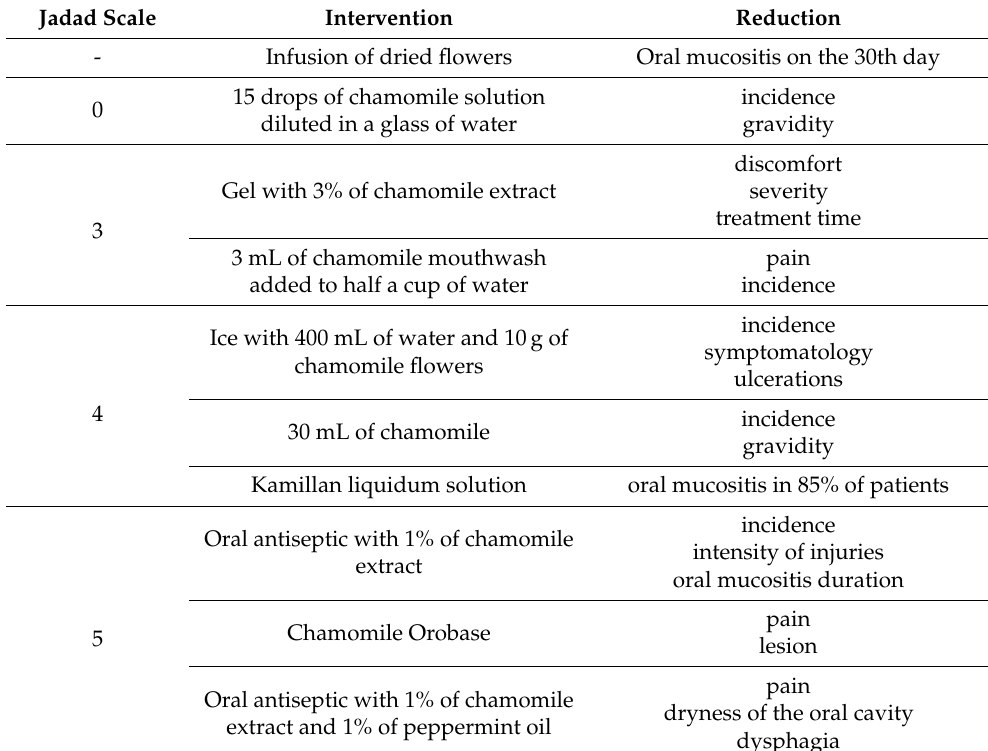
Table 5. Clinical trials on the effectiveness of Matricaria recutita (L.) for the treatment of oral mucositis (Adapted from